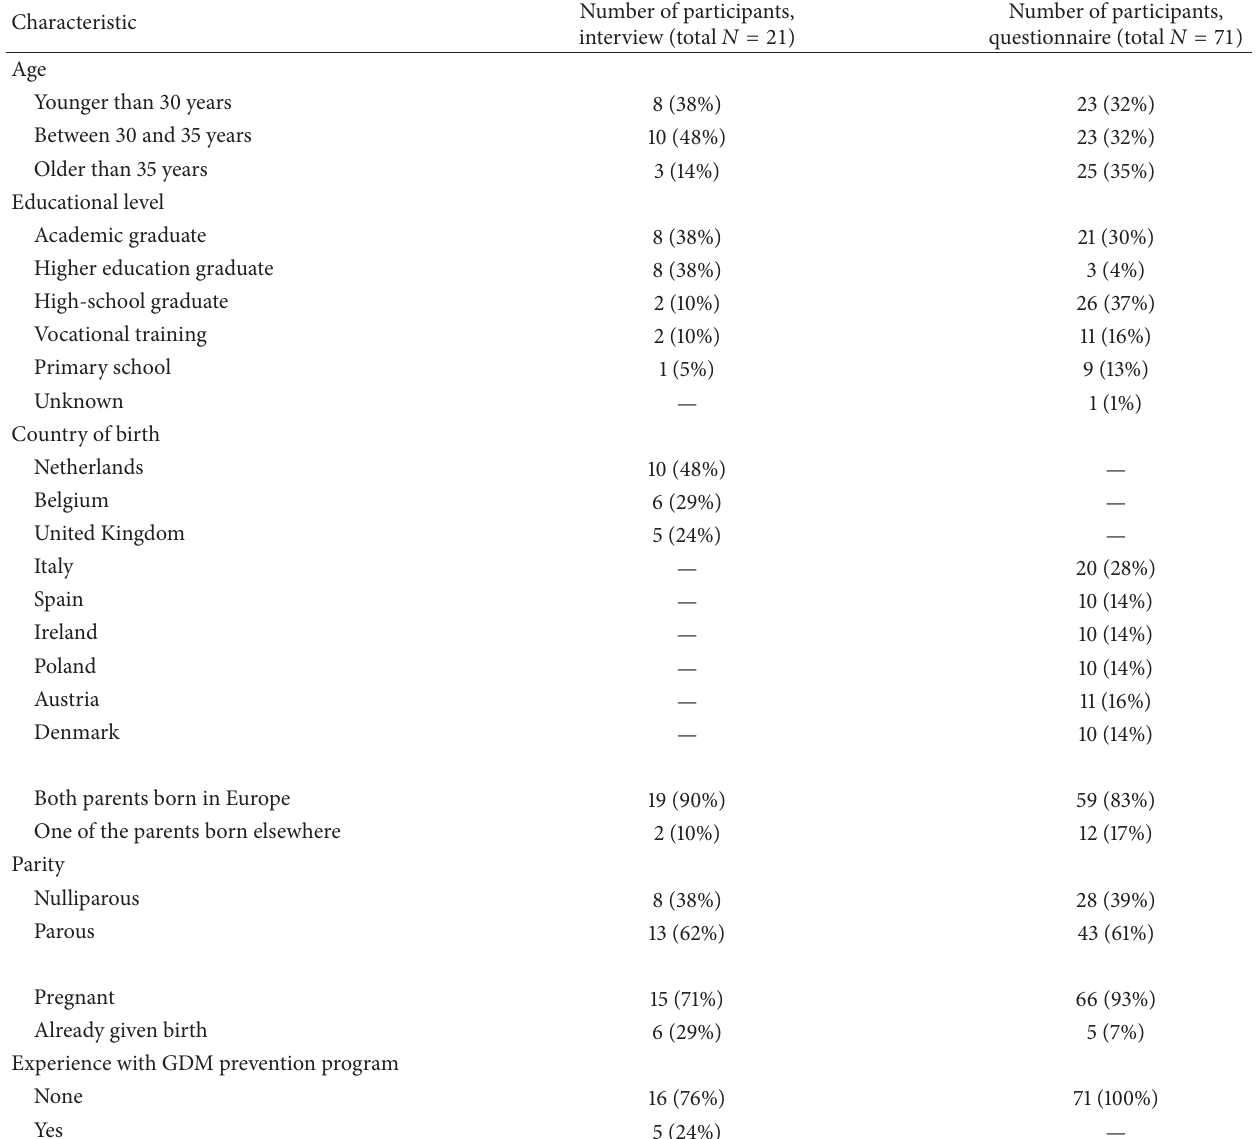
Table 1: Characteristics of participating overweight and obese pregnant women ( 𝑁 = 92